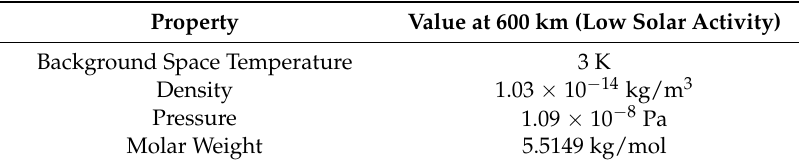
Table 2. Atmospheric Properties at a 600 km Altitude [10].